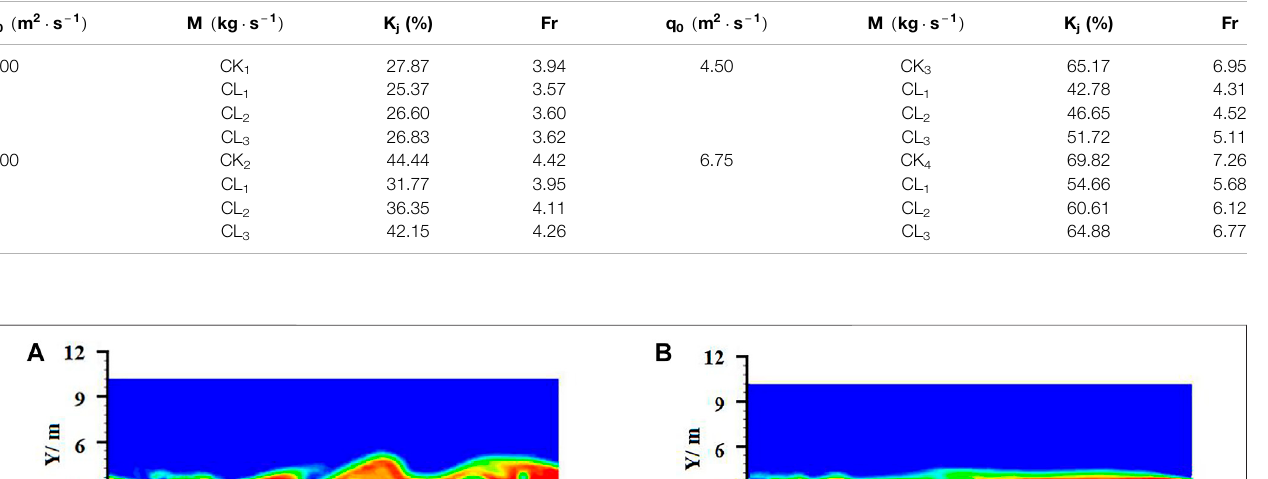
Frontiers in Earth Science |